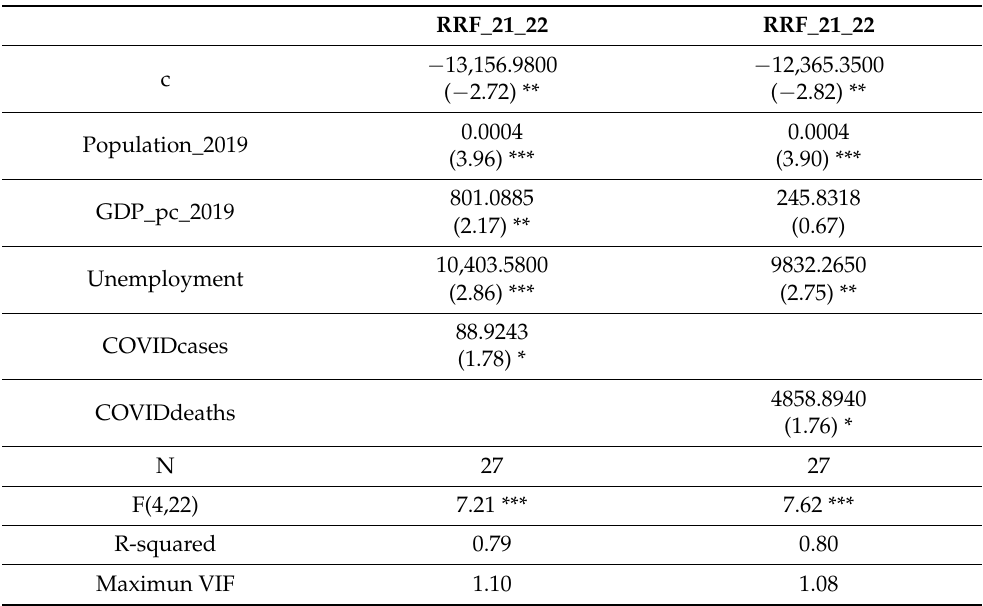
Table 6. Relationship between socioeconomic and health criteria and the amount of grants that Member States will actually receive in the period